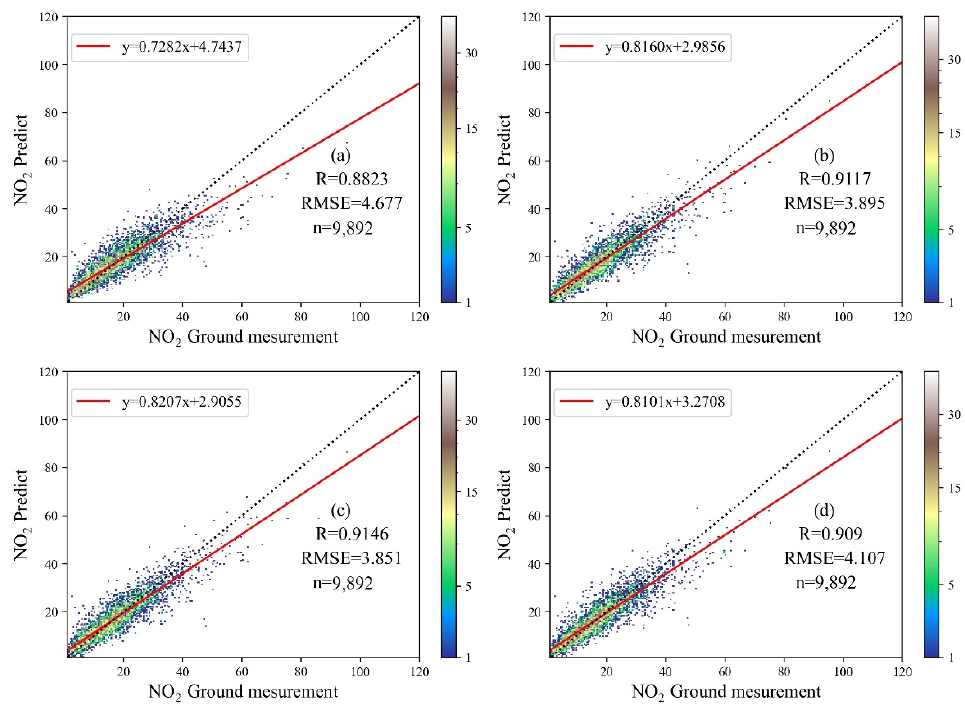
Figure 4. CV diagram of the verification dataset. CV for ( a ) RF, ( b ) RF–RID, ( c ) RF–CID, and ( d ) RF–Ps. The dashed line represents the 1:1 ratio line, the solid red line represents the first-order linear fitting function curve, and the colored column represents the point